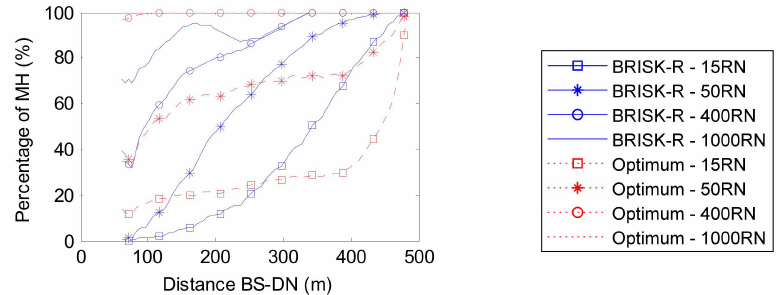
Figure 8. Percentage of transmissions for which the mode selection scheme selects MH—web tra ffi c & homogeneous scenario.